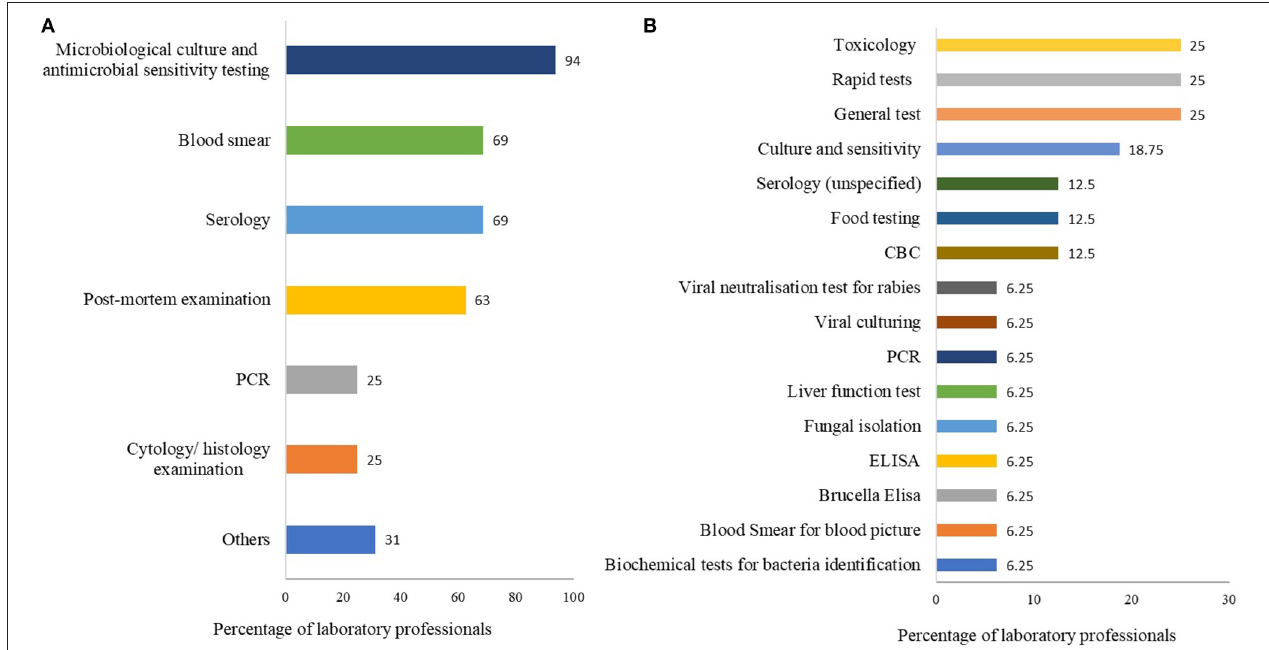
FIGURE 2 | (A,B) The most common tests requested by clients. Graph (A) represents tests requested for which labs have capacity to test; (B) represents tests requested but laboratories have no capacity to tests. Both questions had multiple responses. Bars represent percent of laboratory technicians ( n = 16) that selected each